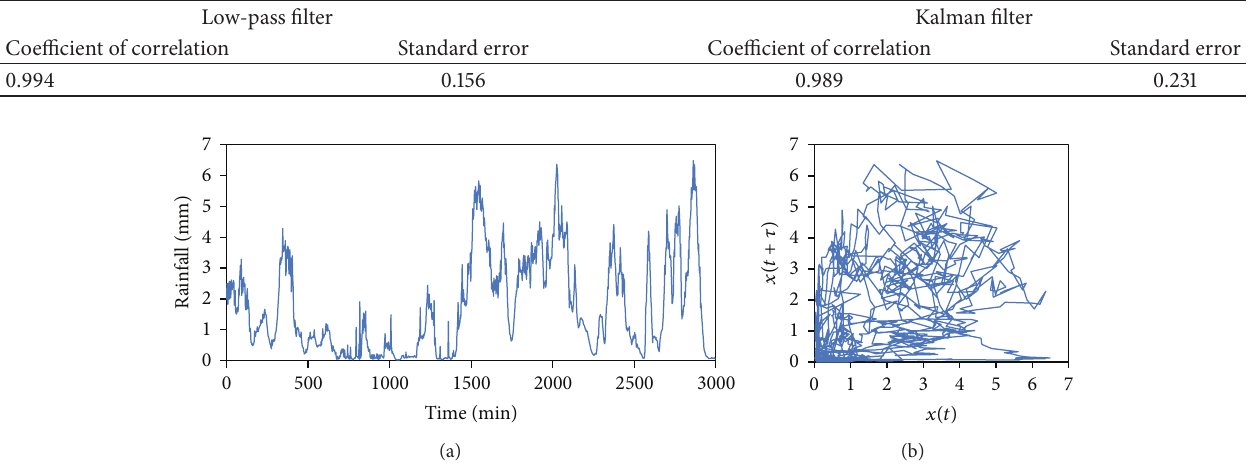
Table 3: Statistical characteristics of radar rainfall after applying the filtering techniques.